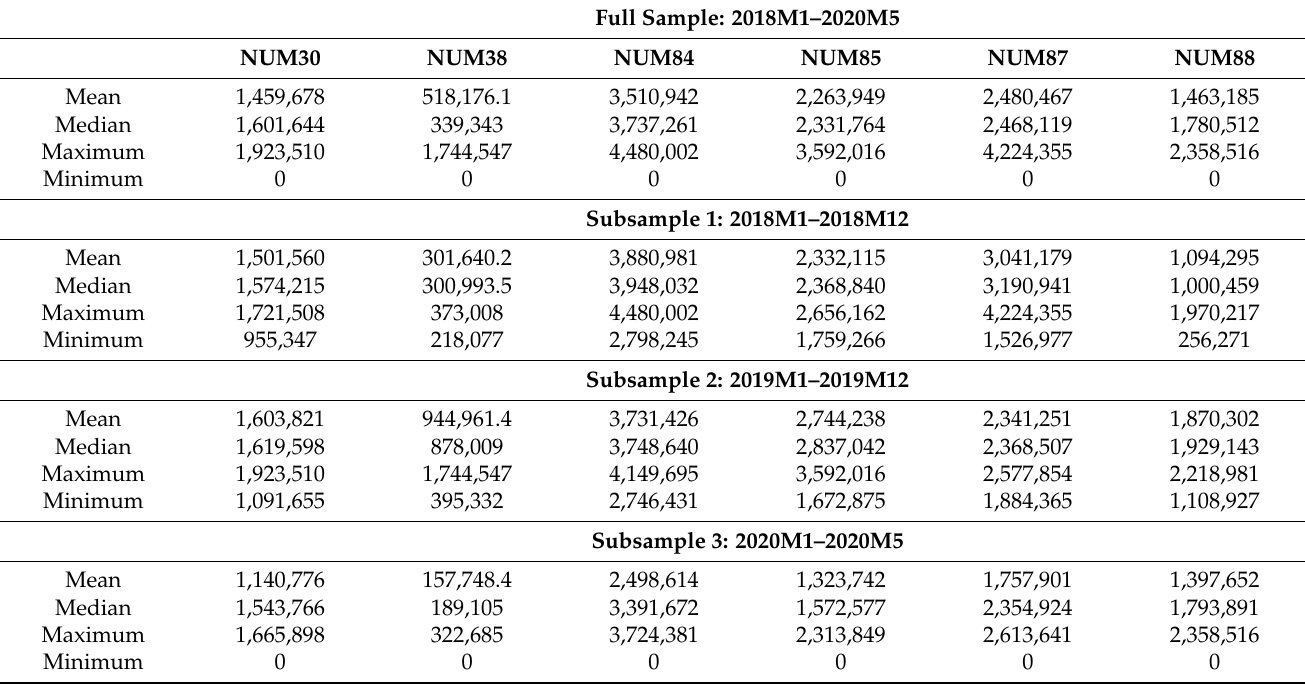
Table 4. Descriptive statistics ($) of imports of EU-15 for sample and